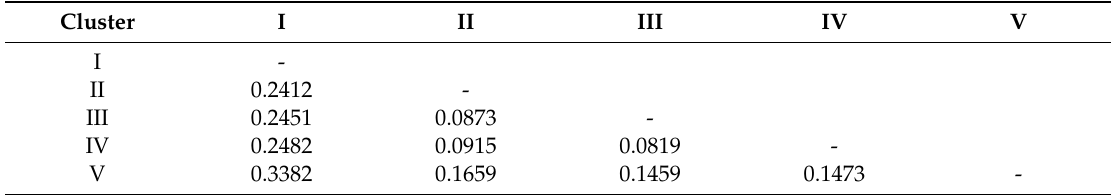
Table 5. Genetic distance between all pairings of clusters based on SSR